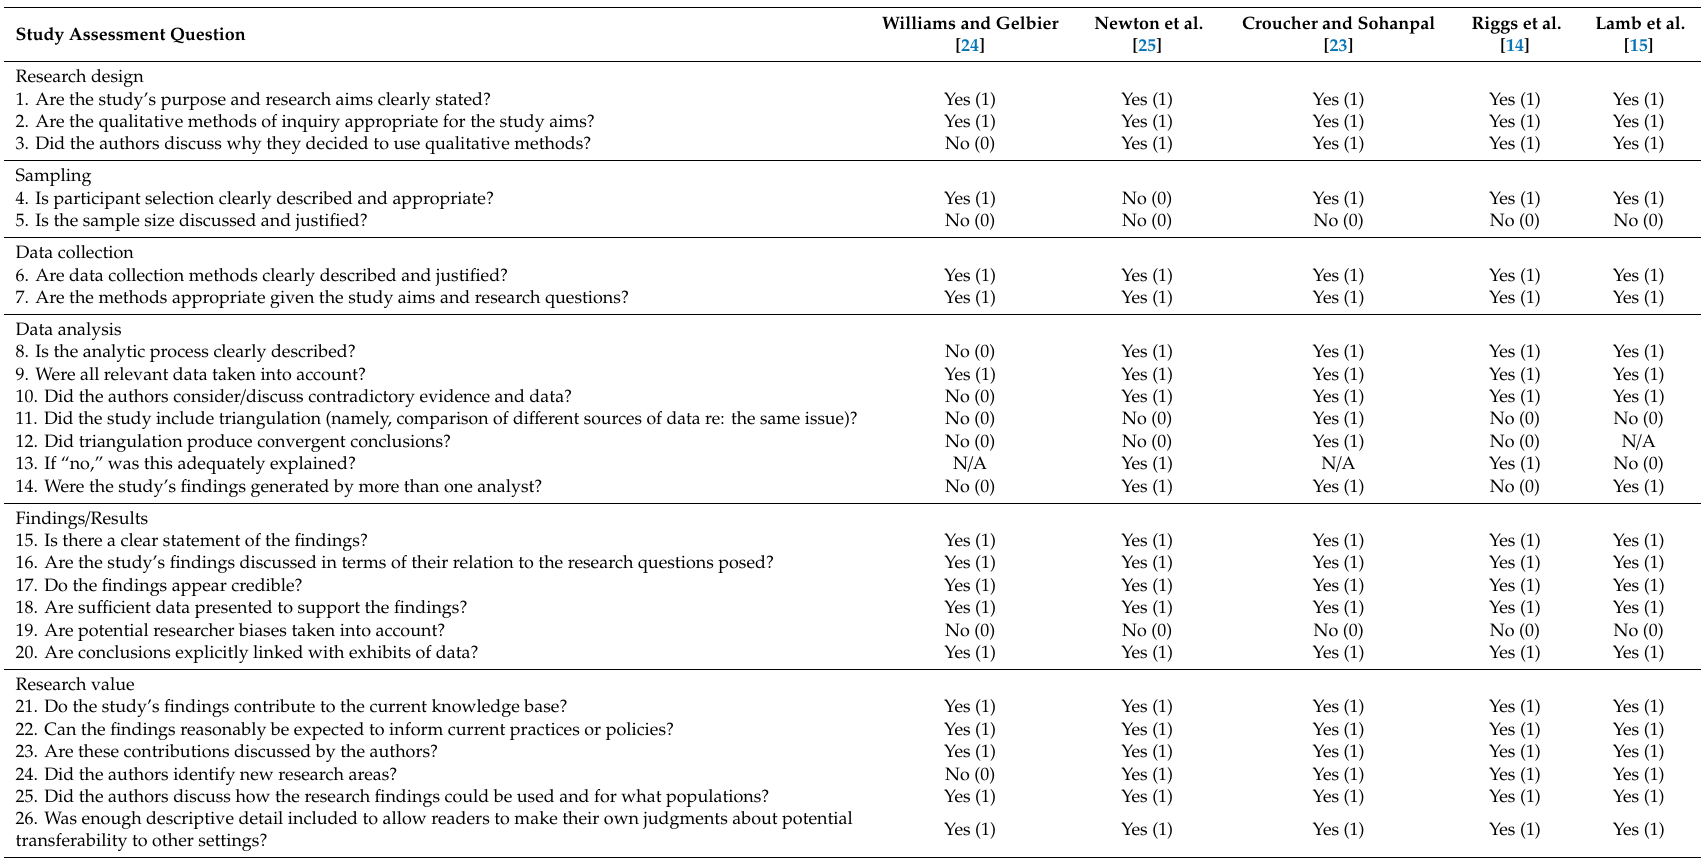
Table A2. Quality assessment of qualitative studies